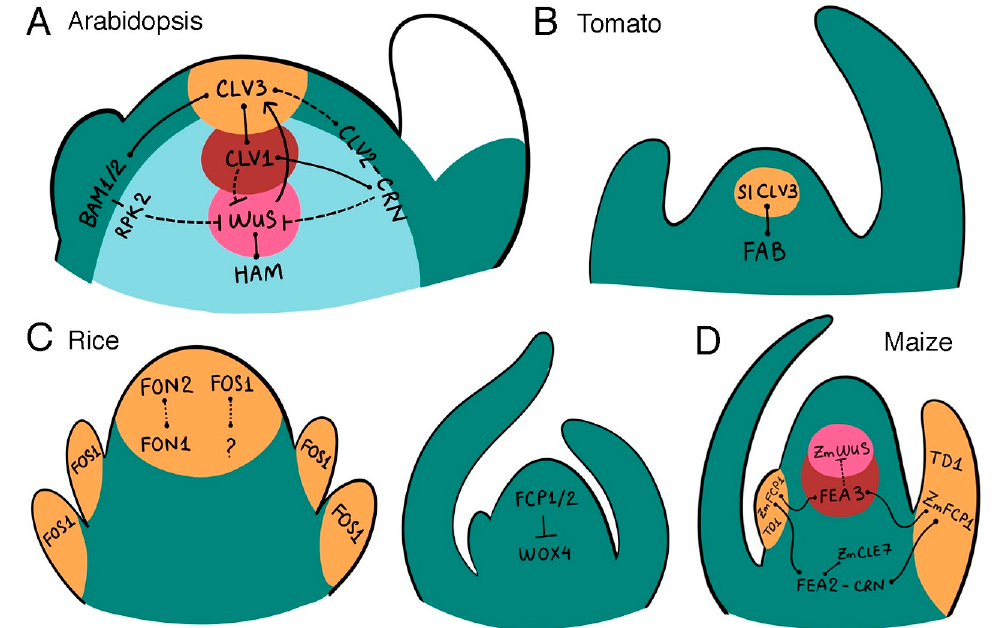
Figure 2. CLV-WUS signaling pathways in model and crop plant meristems. ( A ) Arabidopsis SAM. ( B ) Tomato SAM. ( C ) Rice FM and SAM. ( D ) Maize SAM. Genes with characterized genetic and/or biochemical interactions are shown. Arrows depict positive regulation and bars depict negative regulation. Solid lines represent direct interactions and dashed lines represent indirect interactions. Solid lines with rounded ends depict direct peptide–receptor interactions. Unidentified receptors for peptides are denoted by question marks.